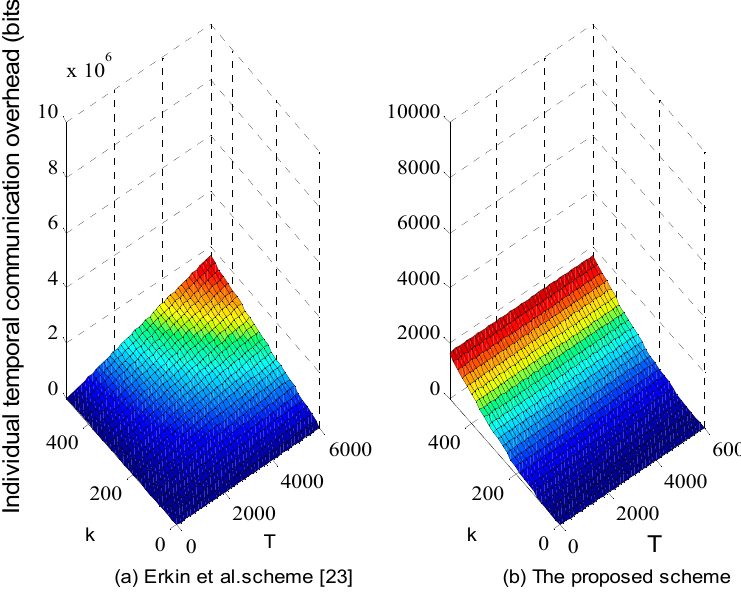
Figure 7. Variety of temporal communication overhead per node with the values k and T.